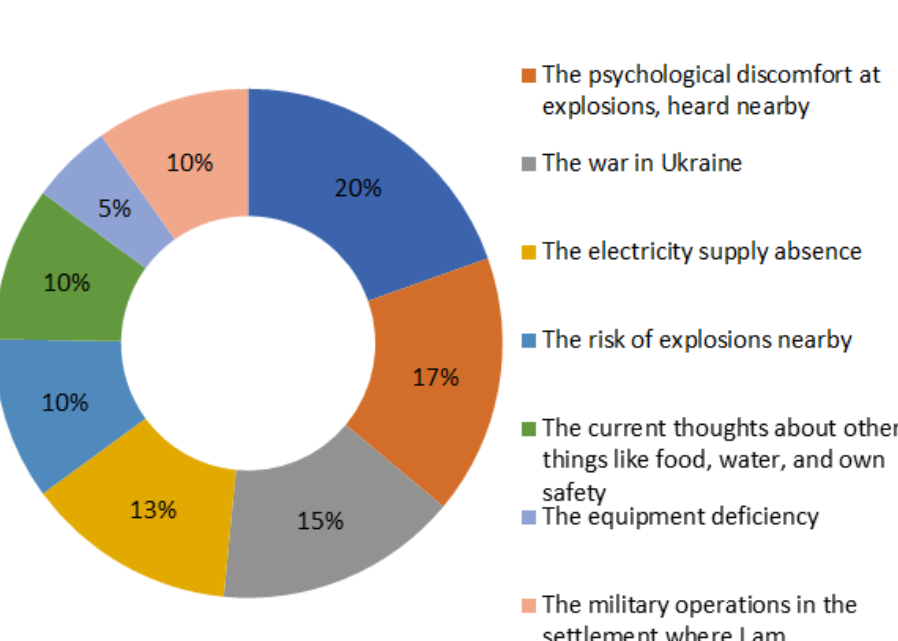
Figure 4. Significant difficulties, due to which students cannot study at the appropriate level (image developed by the authors).